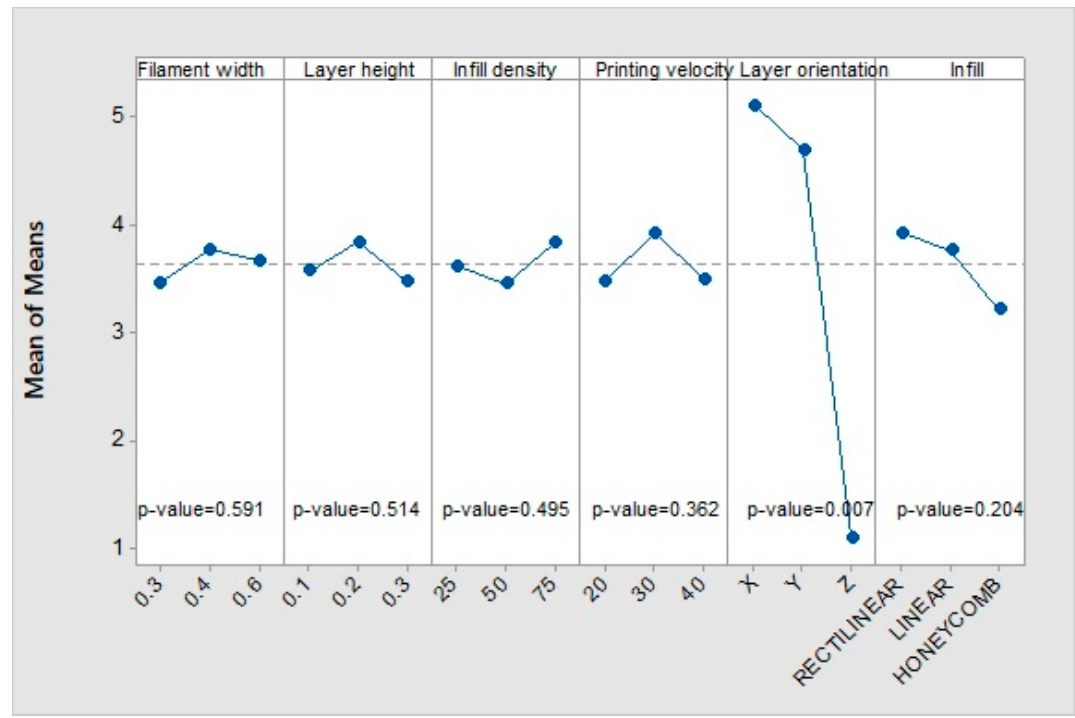
ff ects of means for maximum Figure 13. Main effects of means for maximum deformation. Figure 13. Main e